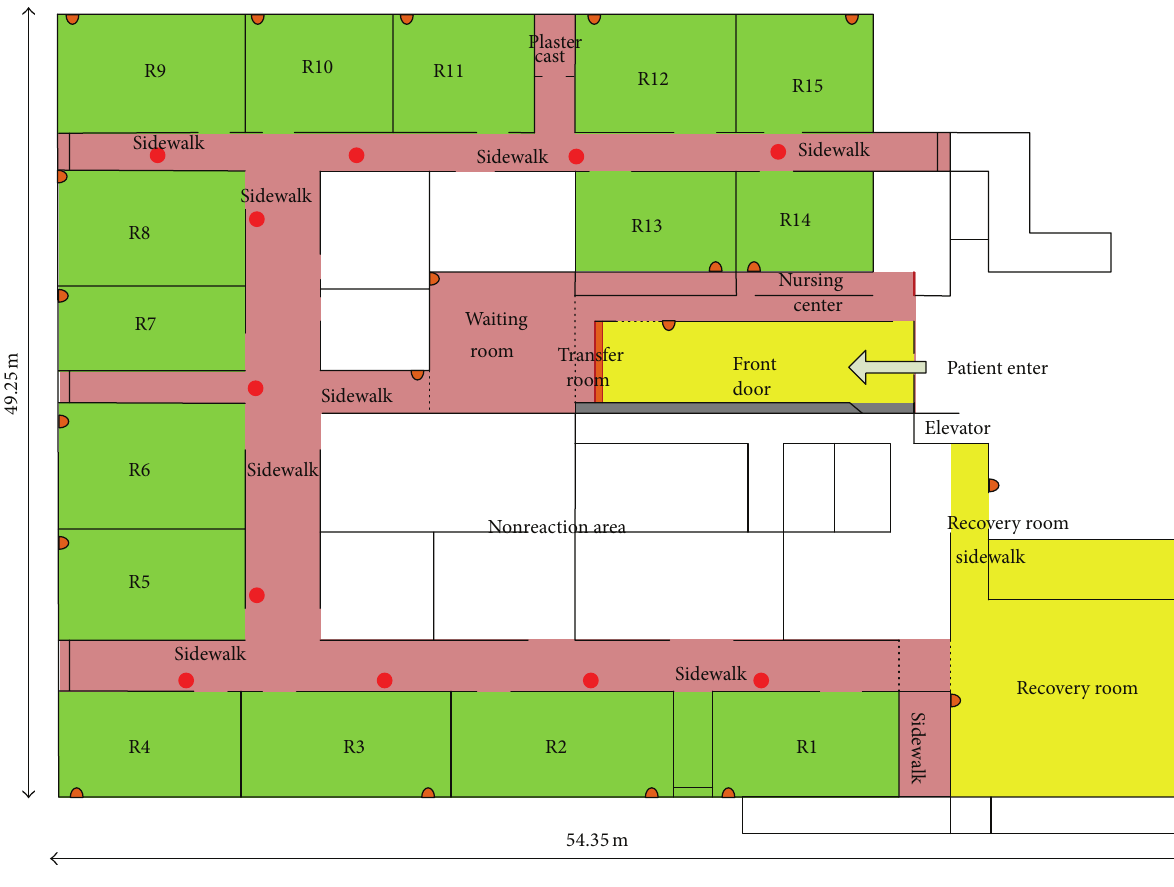
Figure 8: A simulated installation of RFID readers with 6-meters distance between two readers in the surgery